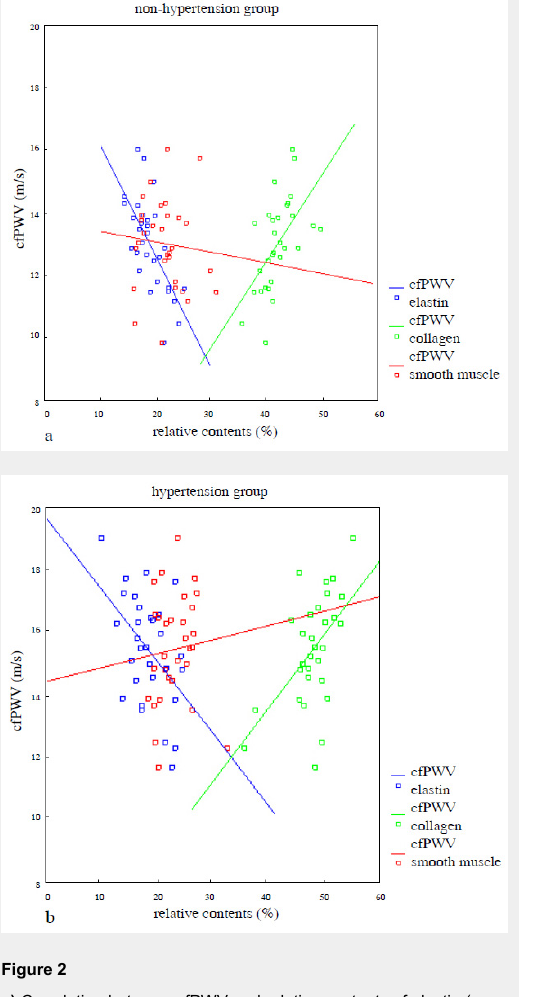
a) Correlation between cfPWV and relative contents of elastin (r = –0.669, 95%CI: –0.517~–0.206, P <0.01), collagen (r = 0.576, 95%CI: 0.127~0.436, P <0.01) and smooth muscle (r = ‒0.089, 95%CI: –0.181~0.113, P = 0.638) of the aortic media in the